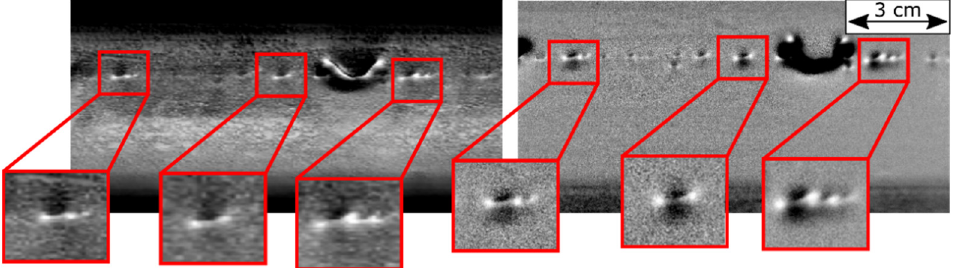
Figure 14. Comparison of cracks detected with scanning (left image) and cracks detected with stationary measurement (right image).